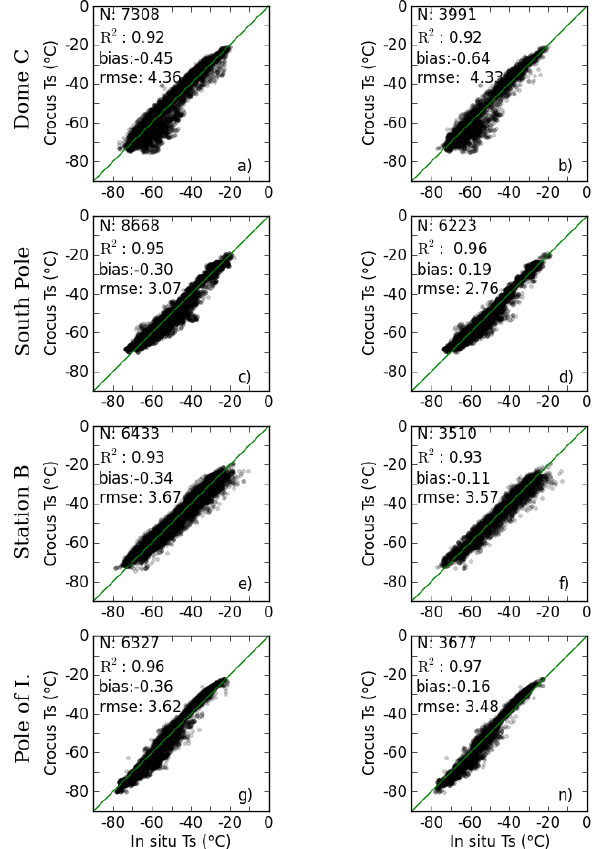
Figure 6. Comparisons of Crocus T s and in situ T s at (a) Dome C, (c) South Pole, (e) Plateau Station B and (g) Pole of Inaccessibility. Same comparisons but only when MODIS T s values are available at the same time: (b) Dome C, (d) South Pole, (f) Plateau Station B and (h) Pole of Inaccessibility. The green line represents the 1:1